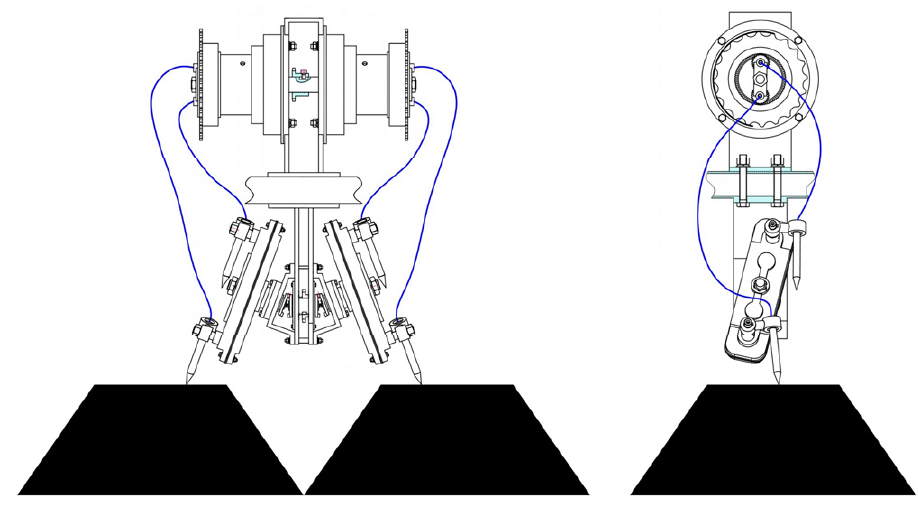
Figure 6. Hose connection type.